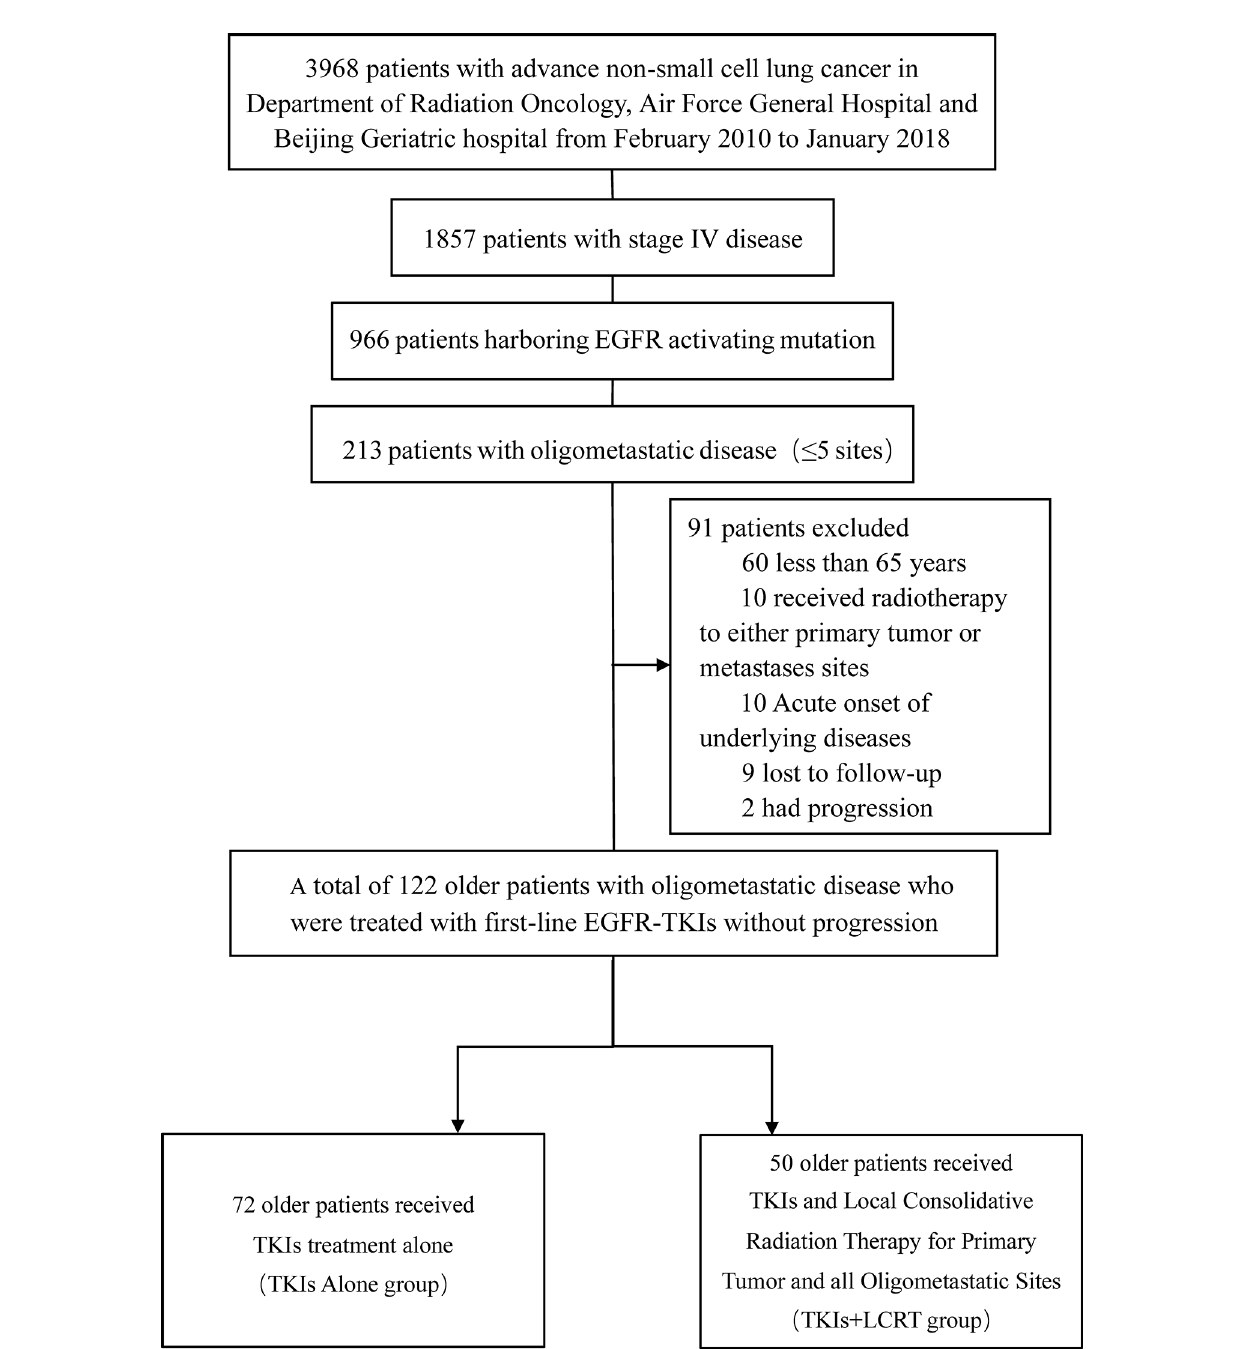
FIGURE 1 | Flowchart showing selection process for patients. EGFR, Epidermal Growth Factor Receptor; TKIs, Tyrosine Kinase Inhibitors; LCRT, Local Consolidative Radiation